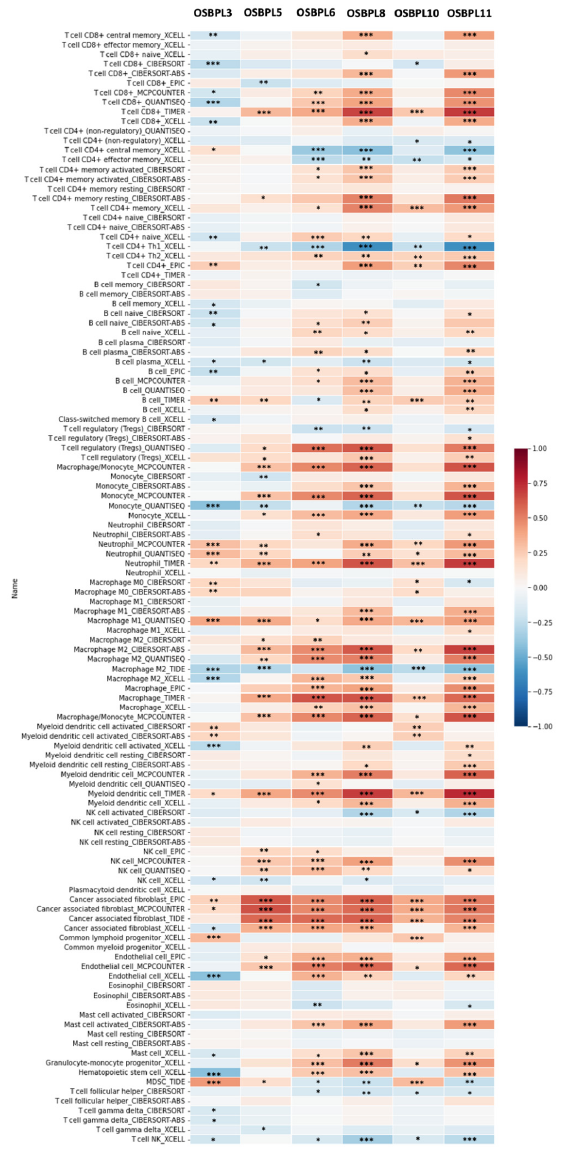
Figure 11. Heatmap of OSBPL3, OSBPL5, OSBPL6, OSBPL8, OSBPL10, and OSBPL11 expressions and immune infiltrates in pancreatic ductal adenocarcinoma (PDAC). The plot indicates correlations of PDAC, and the number of samples out of 116 immune infiltrates methods from six state-of-the-art algorithms, consisting of TIMER, EPIC, CIBERSORT, xCell, MCP-counter, and quantization. R-scores ranged − 1.0 − 1.0. A value of r = 1 denotes a perfect positive correlation, while a value of r = − 1 shows a perfect negative correlation. *: p < 0.05; **: p < 0.01; ***: p <